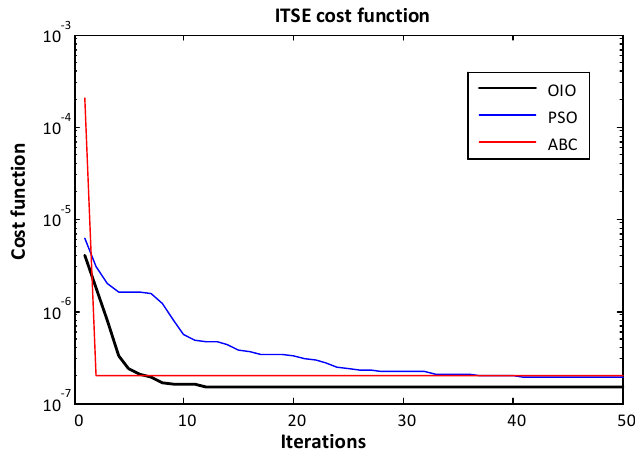
Figure 22. Iteration history for ITSE.